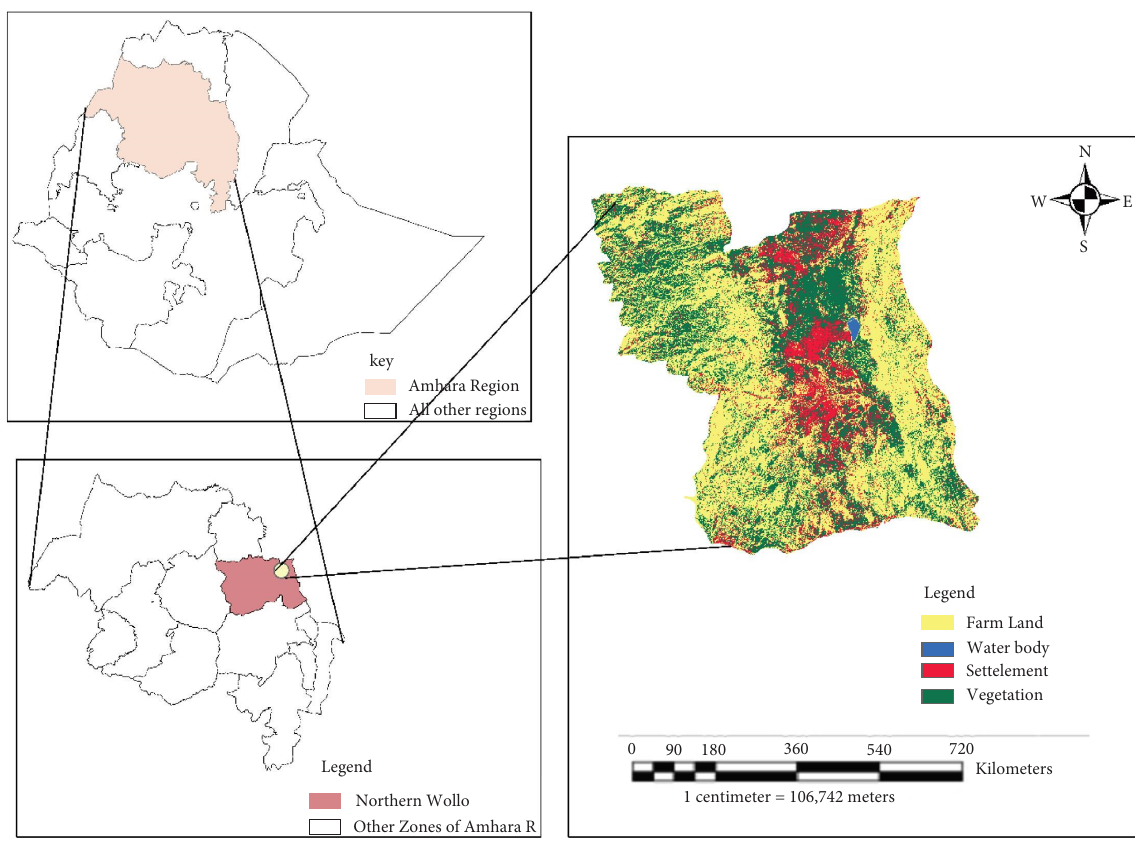
Figure 1: Map of the study area. Table 1: Respondents in terms of